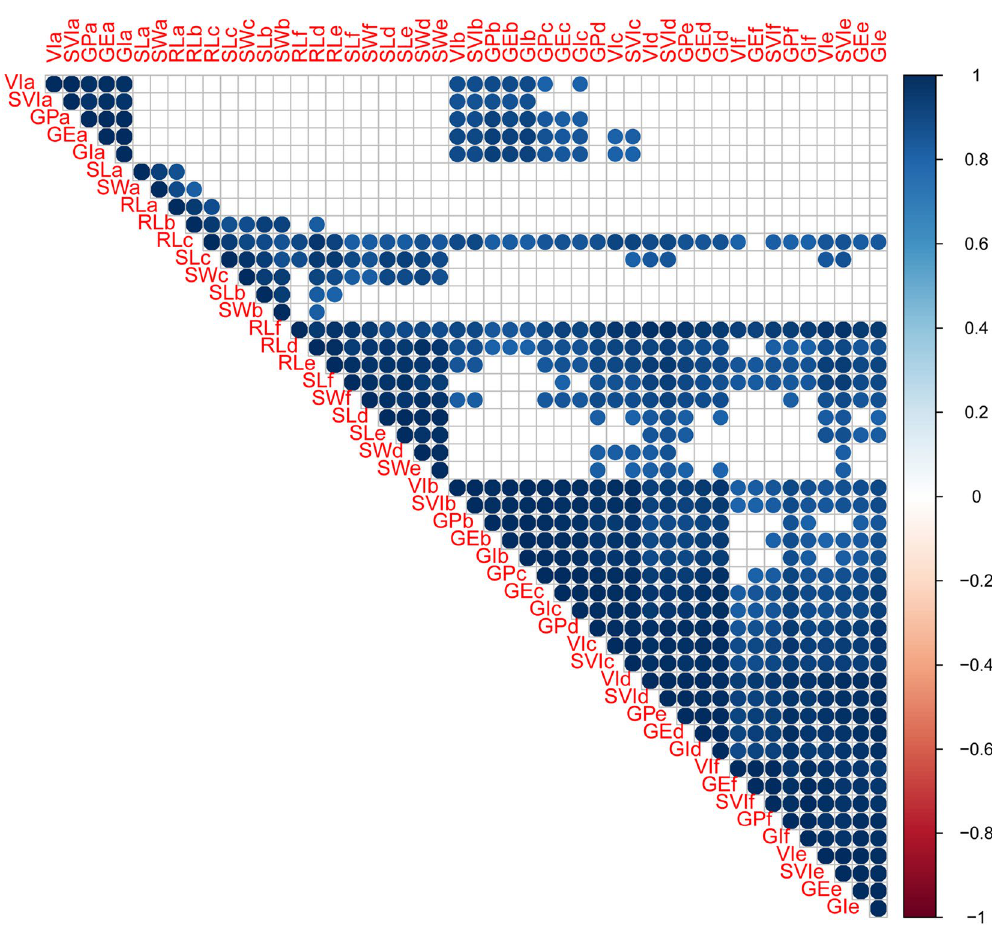
Figure 2. Correlation of seed vigor-related traits in wheat DH